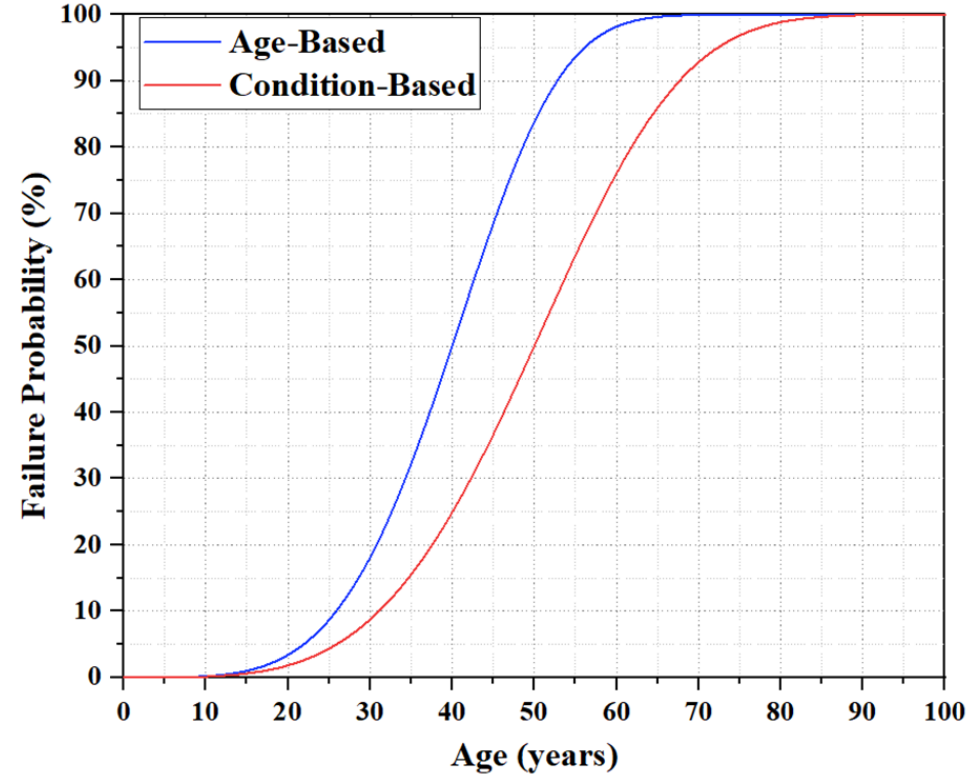
Figure 9. Comparison of age-based and condition-based failure probability curves for UGPCs, considering the cable alone (XLPE, direct-buried, jacketed type).